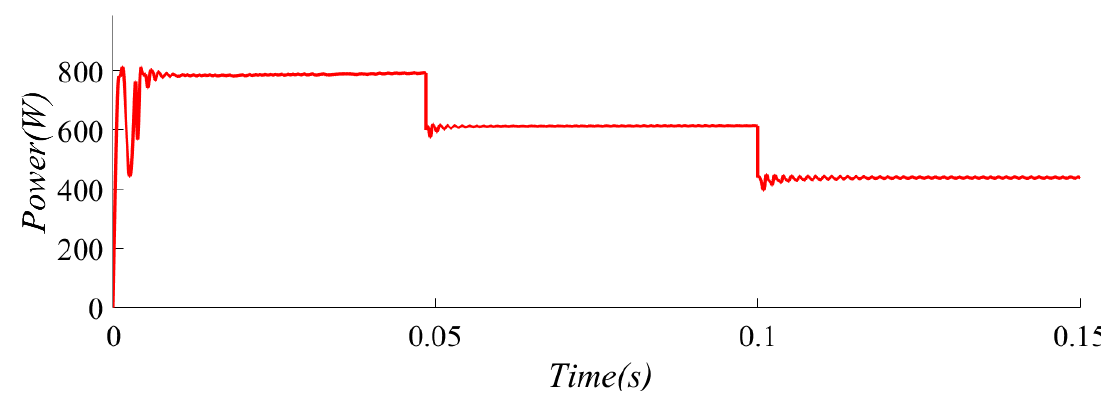
Figure 14. Simulation results when shading situation changes suddenly.